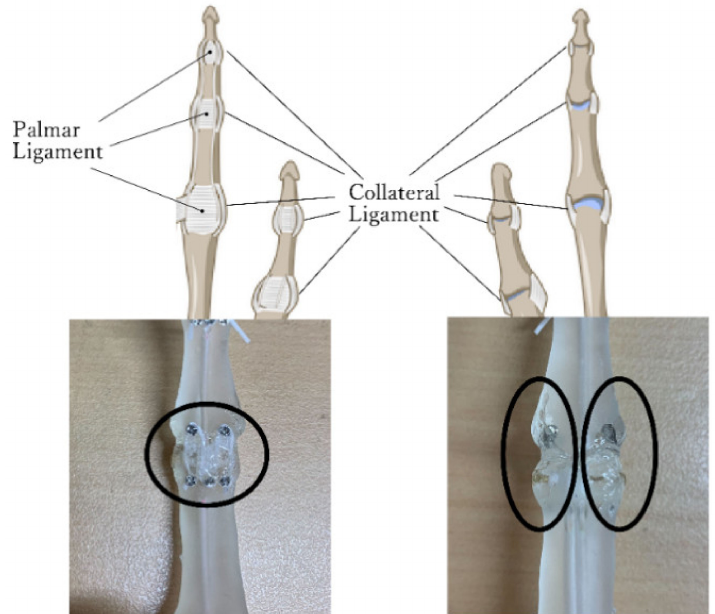
Figure 3. Design of ligaments ( left : collateral ligament, right : palmar